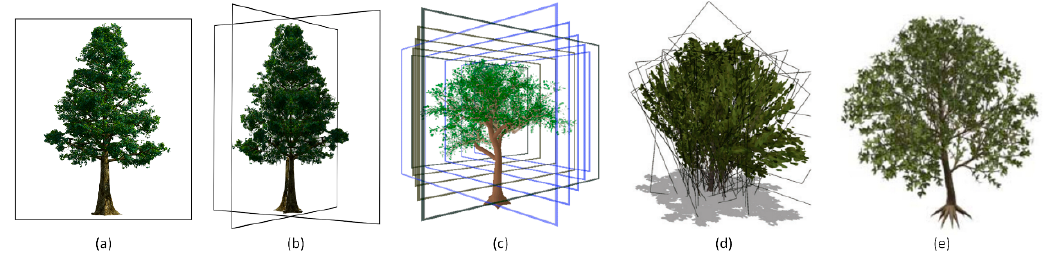
Figure 2. Different cases of billboard-based tree models (IBRTMs): ( a ) a billboard-based tree model; ( b ) a crossed-plane-based tree model; ( c ) the sparse part of a tree approximated by a set of slices (by Jakulin [15]); ( d ) a tree model simplified as a billboard cloud (by Behrendt et al. [16]); ( e ) a simplified tree model based on a hybrid polygon/billboard method (by Lee and Kuo